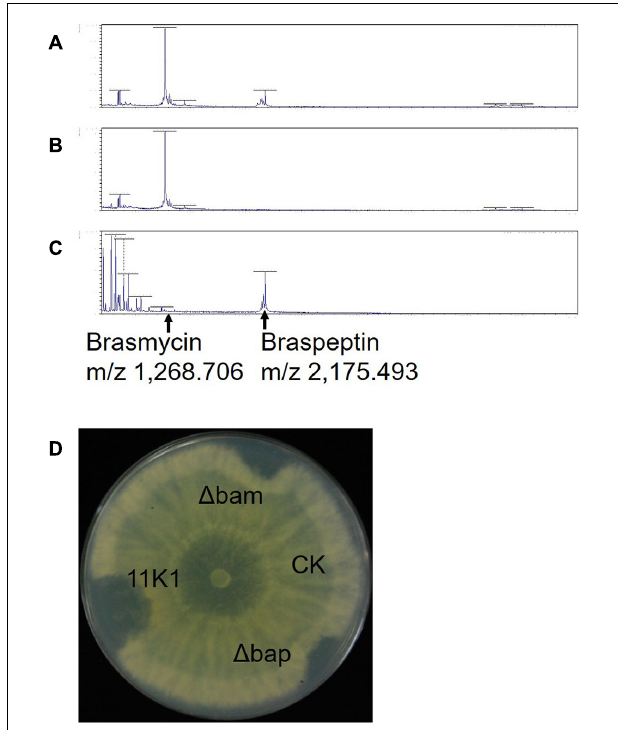
FIGURE 5 | MALDI-TOF MS analysis of CLPs extracted from (A) Pseudomonas sp. 11K1, (B) braspeptin gene cluster mutant (cid:49) bap, and (C) brasmycin gene cluster mutant (cid:49) bam. (D) Antifungal analysis of crude CLP extracts. Inhibition of B. dothidea mycelial growth by crude peptide extracts derived from Pseudomonas sp. 11K1 and its mutants was assessed. Extracts (20 µ L) from 11K1, braspeptin gene cluster deletion mutant (cid:49) bap, and brasmycin gene cluster deletion mutant (cid:49) bam were spotted on agar plates. Methyl alcohol was applied as a control